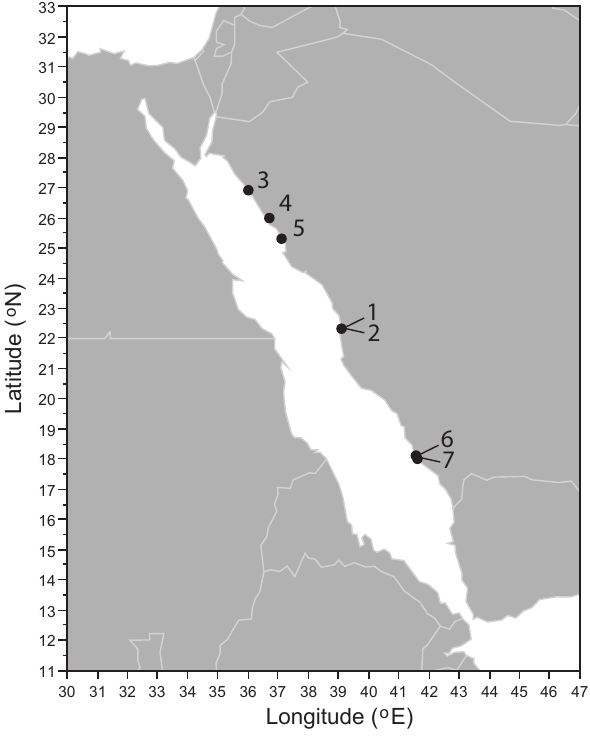
Figure 1. Mangrove stands sampled along the Saudi coast of the Red Sea. Numbers indicate positions of sampling sites from this study. S1 and S2: King Abdullah University of Science and Tech- nology, S3: Duba, S4 and S5: Al Wahj, and S6 and S7: Farasan